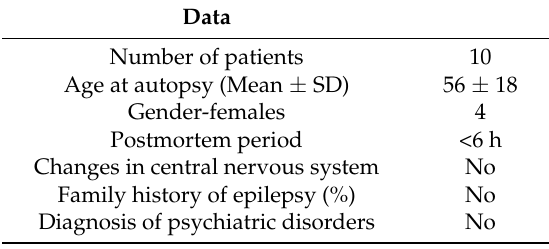
Table 5. Clinical and demographic data of autopsied patients (control